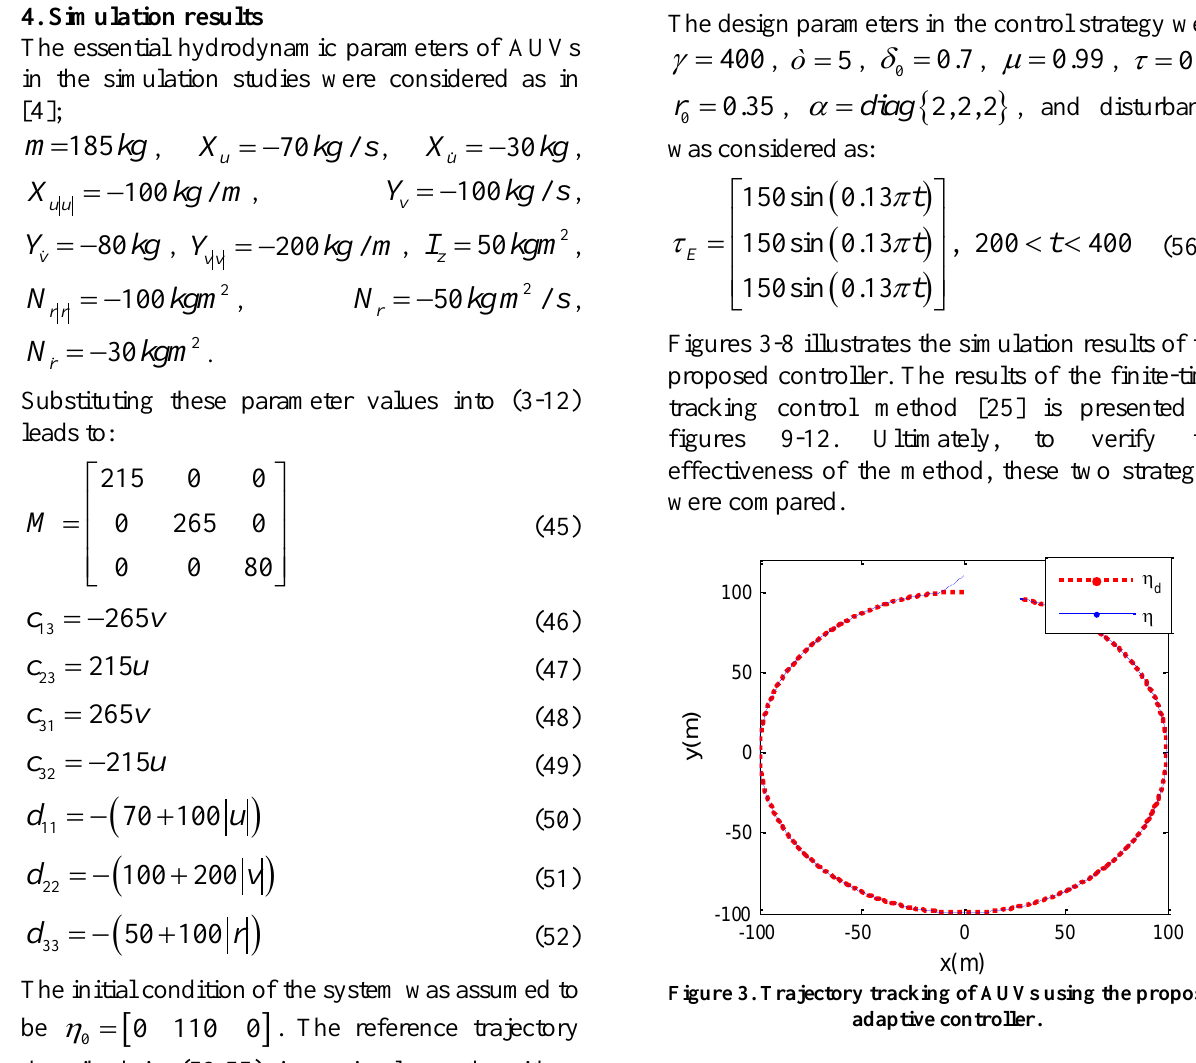
Figure 2. A block diagram of the proposed controller.